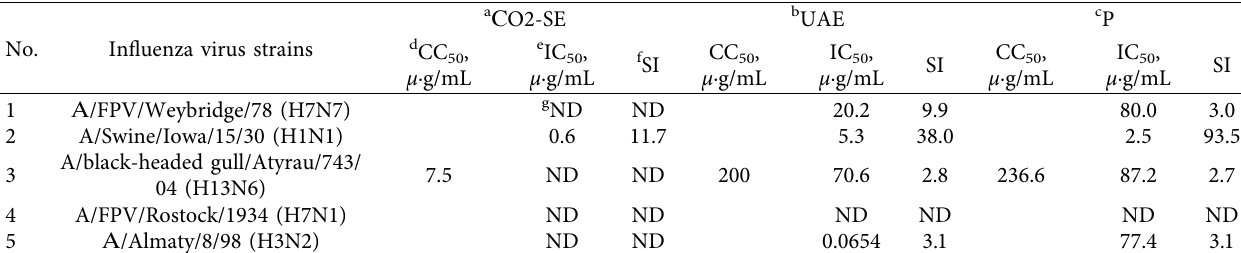
Table 4: Virus inhibition activity of O. gmelinii root extracts on influenza viruses